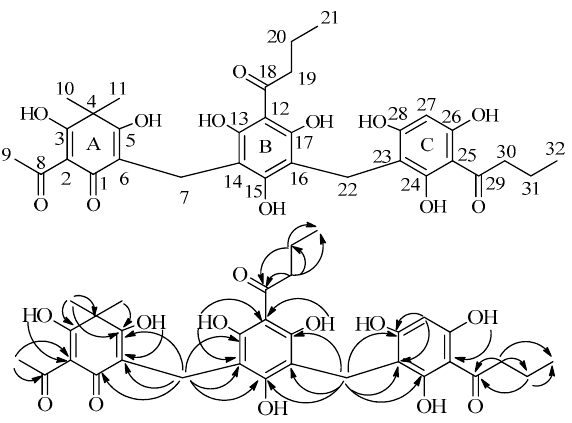
Figure 5. Structure of compound 13 and its HMBC correlations. Table 3. 1 H- and 13 C-NMR spectroscopic data for compounds 13 and trisflavaspidic acid ABB in CDCl 3 .